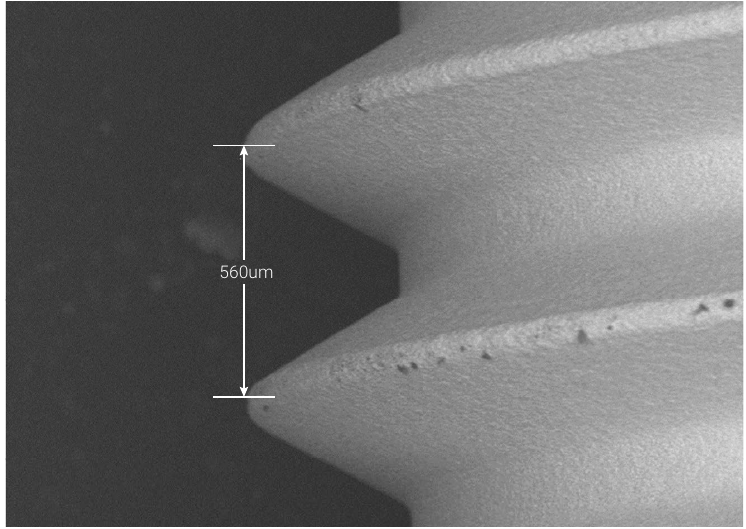
Figure 2. SEM surface image and software vortex to vortex measurement.